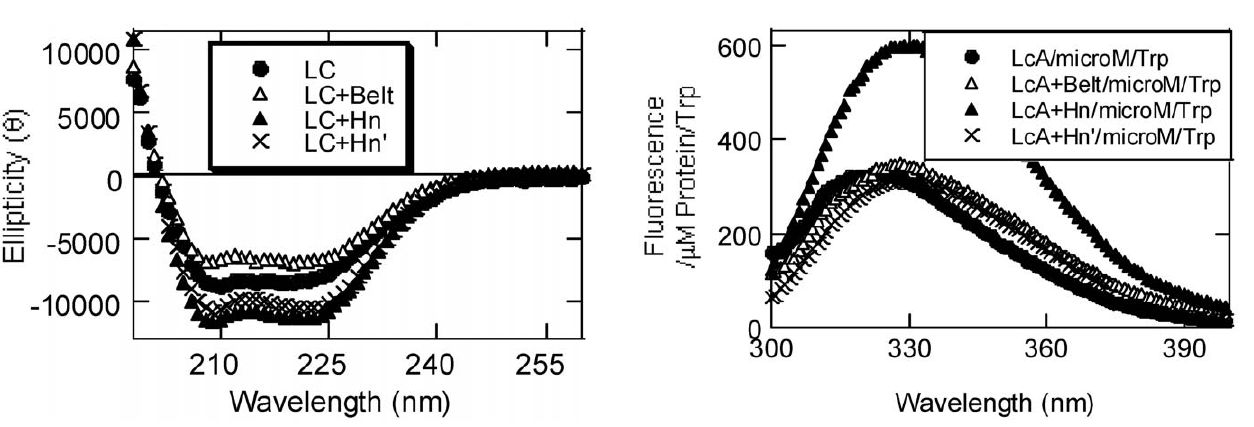
Figure 4. Far-UV CD spectra of LC variants at 20 u C. Average of five spectra were collected for 0.2 mg/ml of each of LC (closed circle), LC + Belt (open triangle), LC + Hn (closed triangle), and LC + Hn’ (crossed hatch, X) in 50 mM sodium-phosphate, pH 6.5.